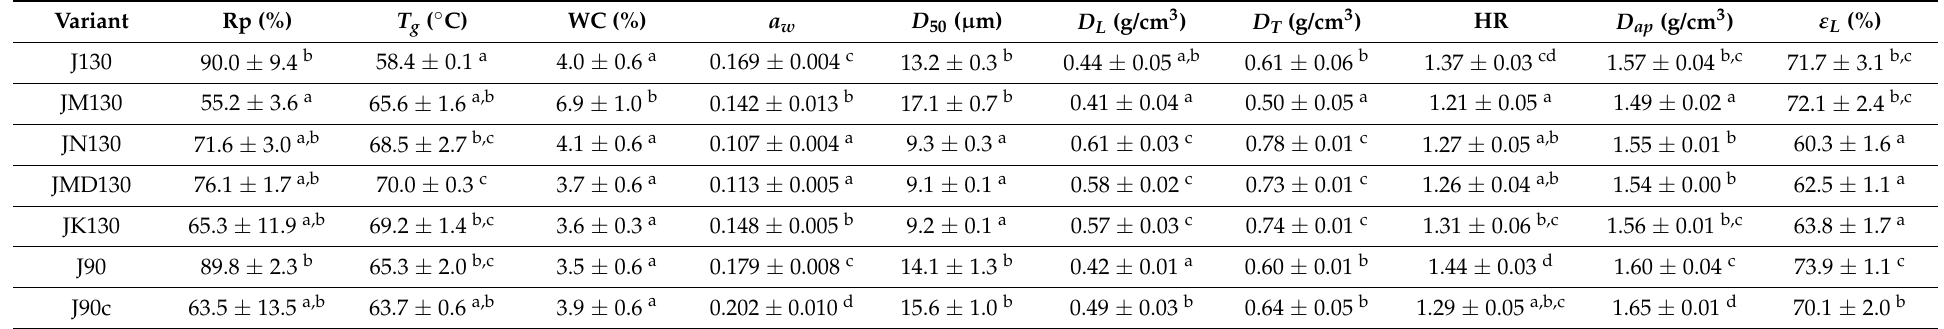
Table 2. Powder recovery ( R P ) and physical properties of obtained powders: glass transition temperature ( T g ), water content (WC), water activity ( a w ), median diameter ( D 50 ), bulk loose density ( D L ), bulk tapped density ( D T ), Hausner ratio (HR), apparent density ( D ap ), and loose bed porosity ( ε L ) (abbreviations of variants explained in Table